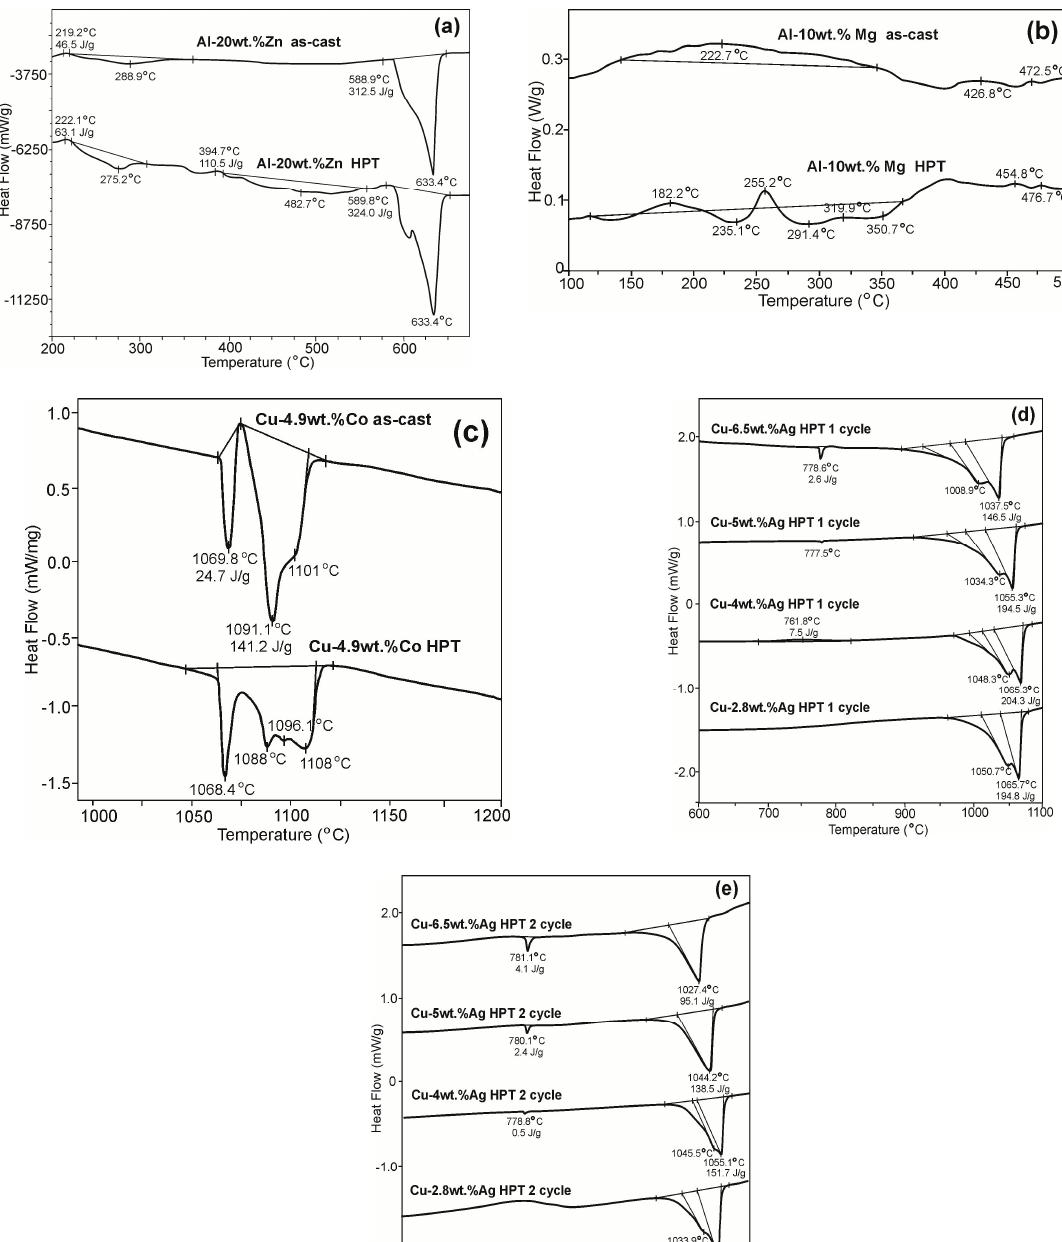
Figure 3. Temperature dependences of the heat flow (DSC curves) for alloys: ( a ) Al-20 wt.% Zn; ( b ) Al-10 wt.% Mg; ( c ) Cu-4.9 wt.% Co before and after HPT-treatment; ( d , e ) Cu-2.8 wt.% Ag, Cu-4 wt.% Ag, Cu-5 wt.% Ag, Cu-6.5 wt.% Ag after HPT-treatment, first heating (d) and second heating (e).